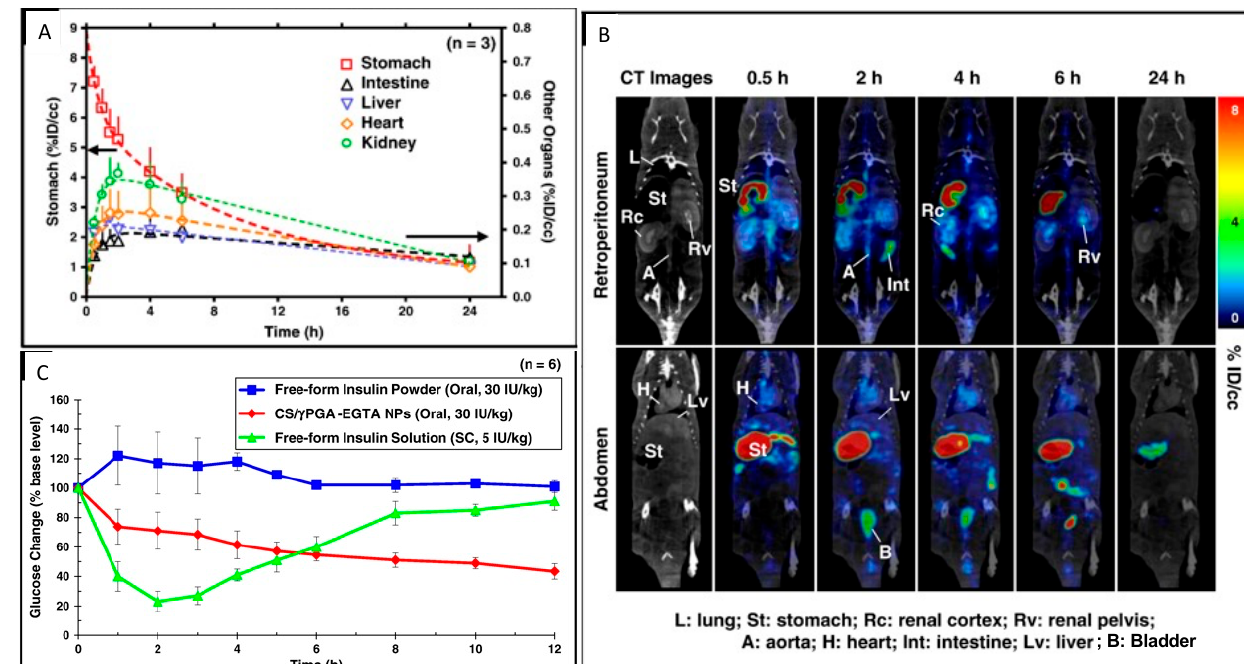
Figure 9. ( A ) Organ activities and ( B ) SPECT images of orally ingested 123 I-labeled insulin loaded in nanoparticles, superimposed with soft-tissue contrast CT images at different time points; ( C ) Blood glucose change vs. time profiles of diabetic rats treated with different formulations of insulin. Oral gavaged 123 I-labeled insulin loaded in nanoparticles are in red. Reprinted with permission from Chuang et al. (2013) [110]. Table 2. Summary of SPECT radionuclides and reaction parameters used in the preparation of radiolabeled peptides for pre-clinical and clinical imaging [105,114–117]. a Hydrazinonicotinic acid; b diethylenetriaminepentaacetic acid; c 1,4,7-triazacyclononane-1,4,7-triacetic acid; d 1,4,7,10- tetraazacyclododecane-1,4,7,10-tetraacetic acid; e glucagon-like-phosphate-1 peptide. RT = room temperature. Radionuclide Half-Life (h)